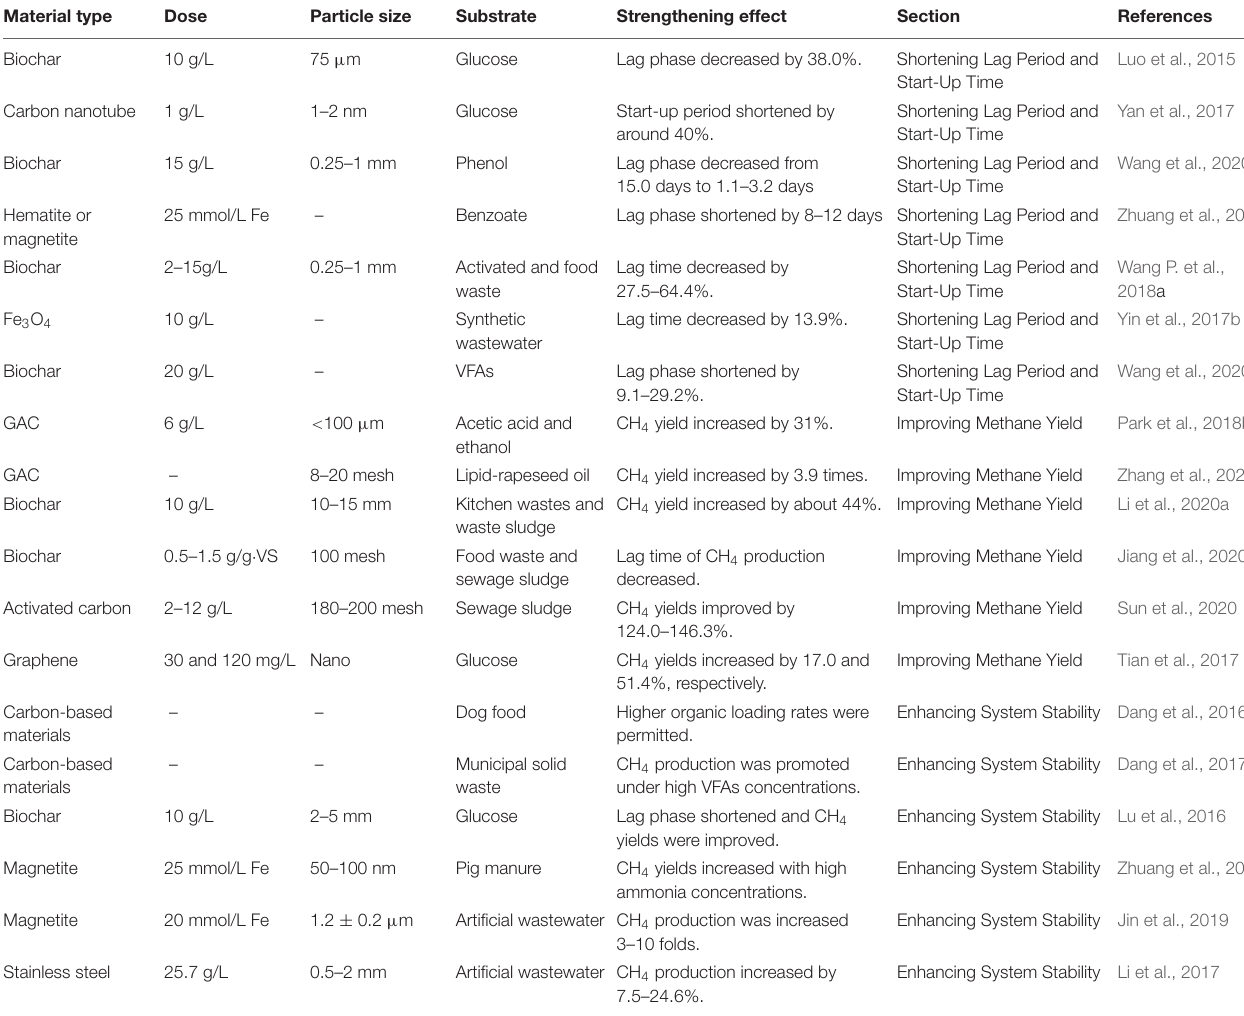
TABLE 2 | Summary of studies regarding enhancement effect of DIET in anaerobic digestion